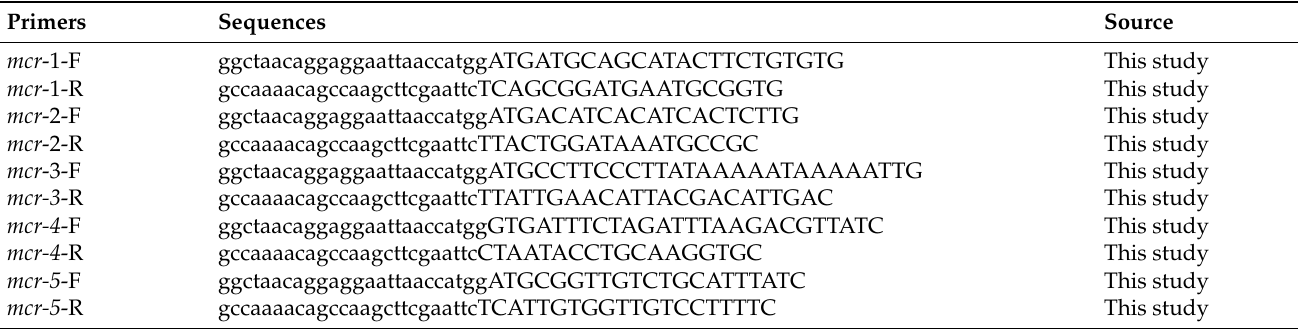
Table A1. Primers used in this